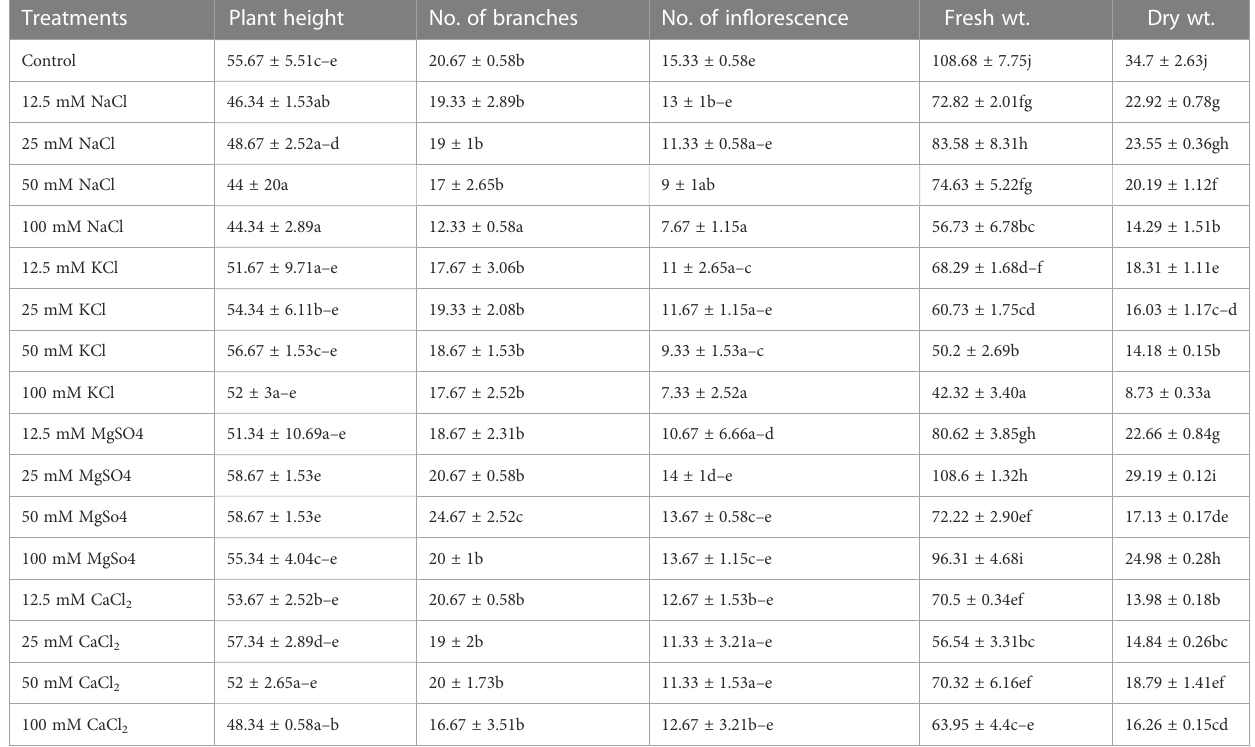
TABLE 3 Effects of different salinity levels on growth, development, and yield of M. longifolia .